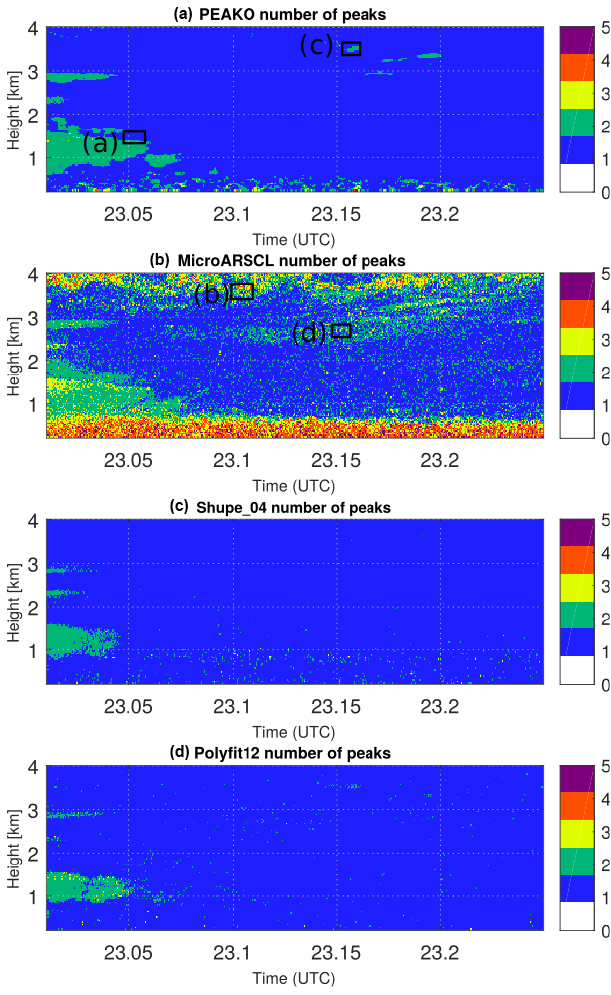
Figure B2. Like Fig. 5 but for 21 February 2014, 23.01–23.25UTC, at 0.2–4km